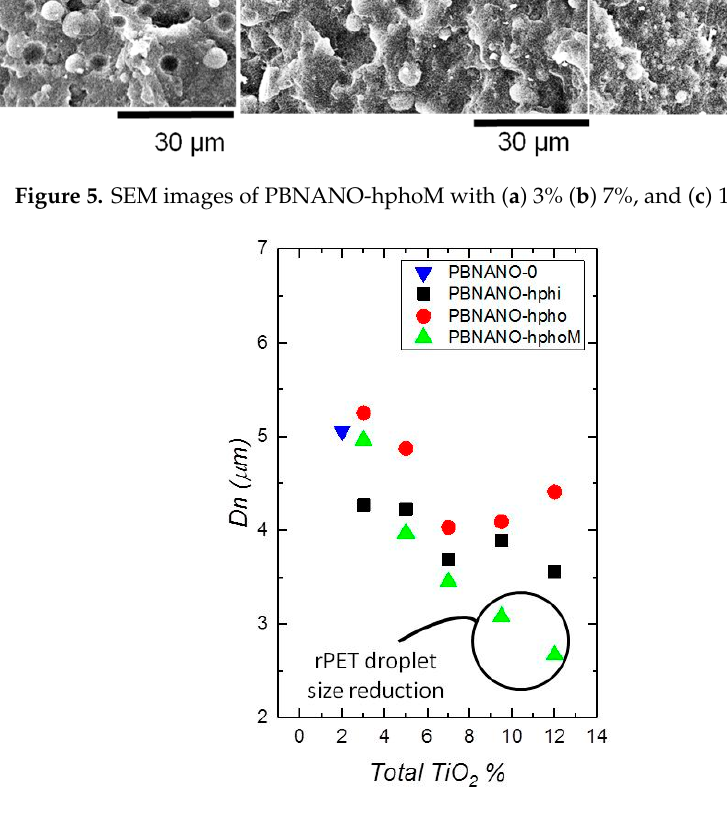
Figure 6. Number average diameter (d n ) plotted as a function of total TiO 2 content for the PBNANOs